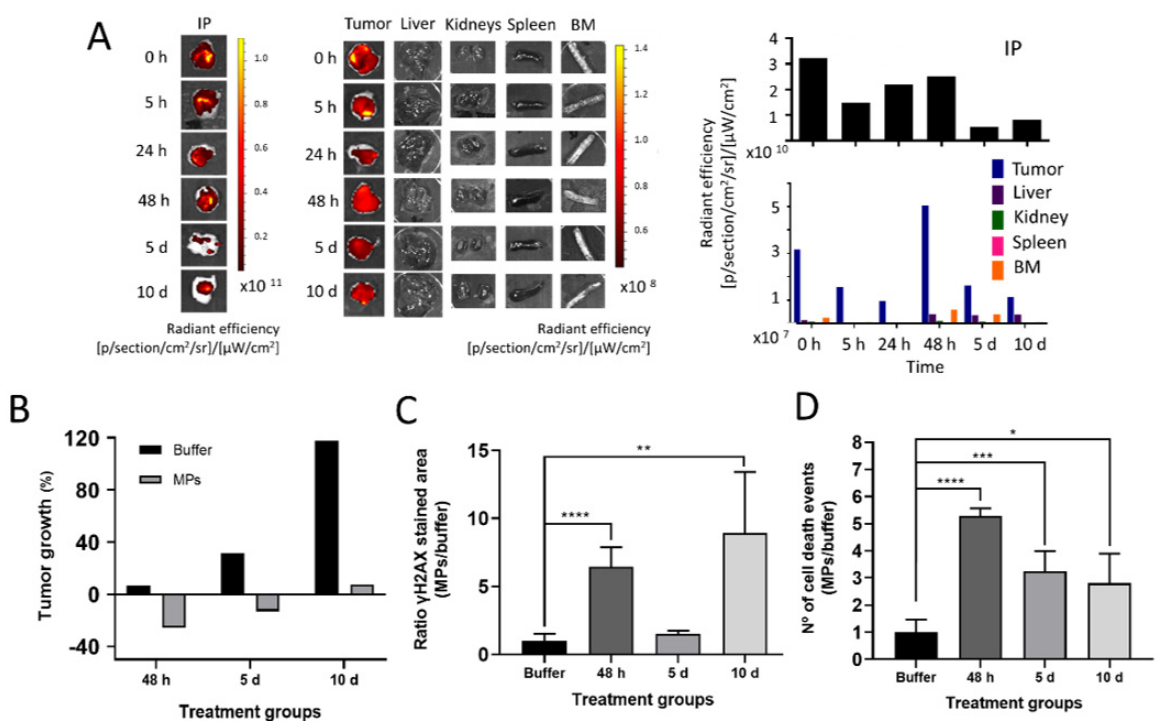
Figure 4. In vivo biodistribution and antitumoral effect of subcutaneously administered protein ‐ MMAE depots in a SC mouse model of CXCR4 + DLBCL − cells. ( A ). Ex vivo fluorescence imaging